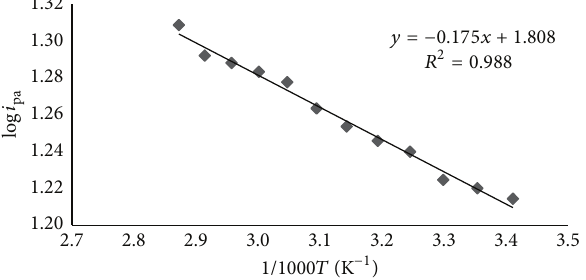
Figure 7: Plot of anodic peak current versus reciprocal of temper- ature for the electrolysis of 0.1 mM paracetamol at a SWCNT/Ni- modified electrode. Scan rate: 100 mVs −1